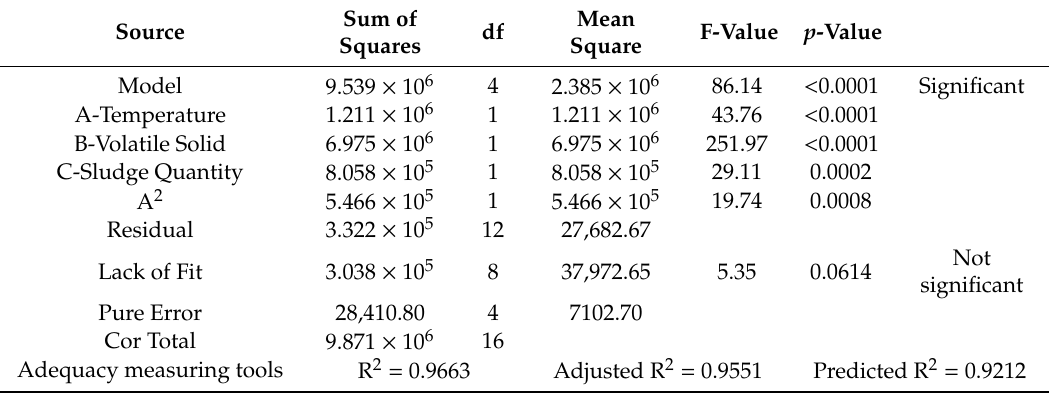
Table 5. ANOVA table for the biogas